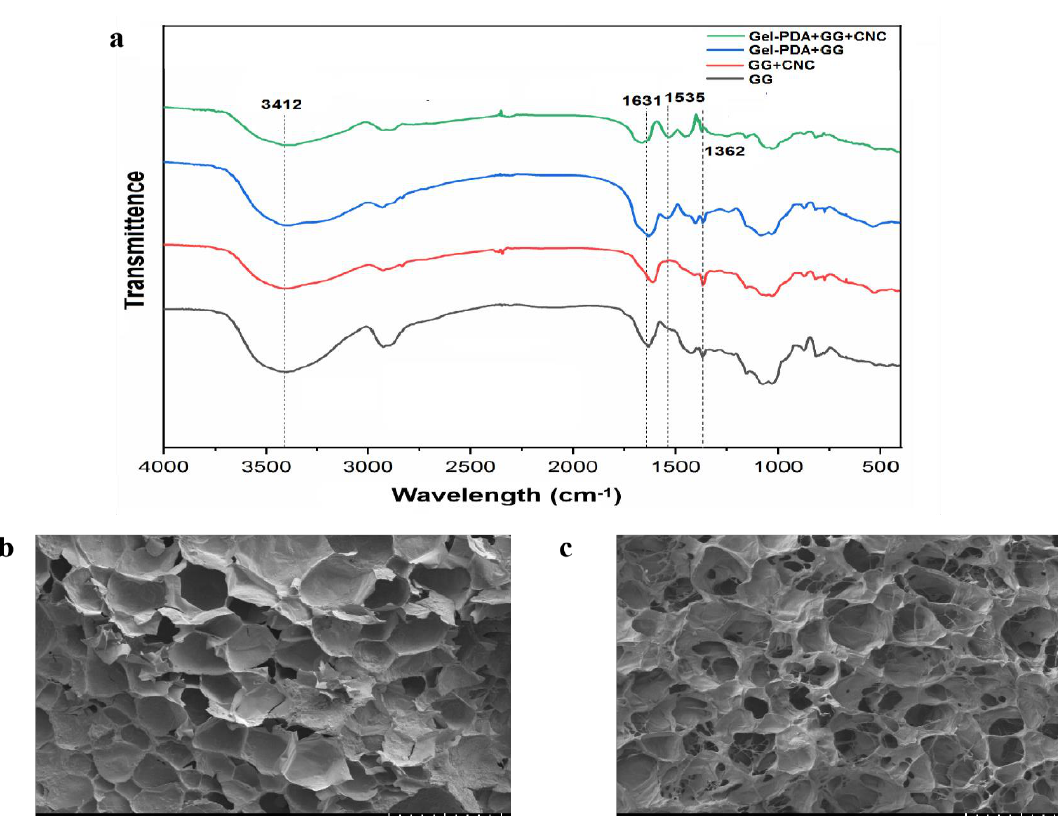
Figure 2. FT − IR and SEM analysis of hydrogels. ( a ) FT − IR spectrum of GG, GG+CNC, Gel − PDA+GG, and Gel − PDA+GG+CNC hydrogel, ( b ) SEM image of hydrogel. ( left ) SEM image of GG hydrogel, ( right ) Gel − PDA+GG+CNC hydrogel.